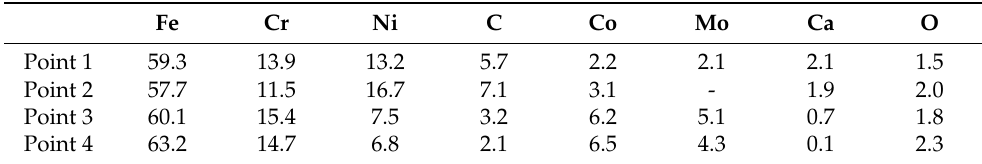
Figure 9. The XRD diffraction pattern of Fe-based powder and coatings: ( a ) Fe-based alloy powder; ( b ) HF coating; ( c ) GF coating; ( d ) comparison of the peak position of Fe-Cr phase in original powder and coatings. Table 9. Elemental concentrations (wt.%) of the selected areas in the GF and HF coatings from EDS